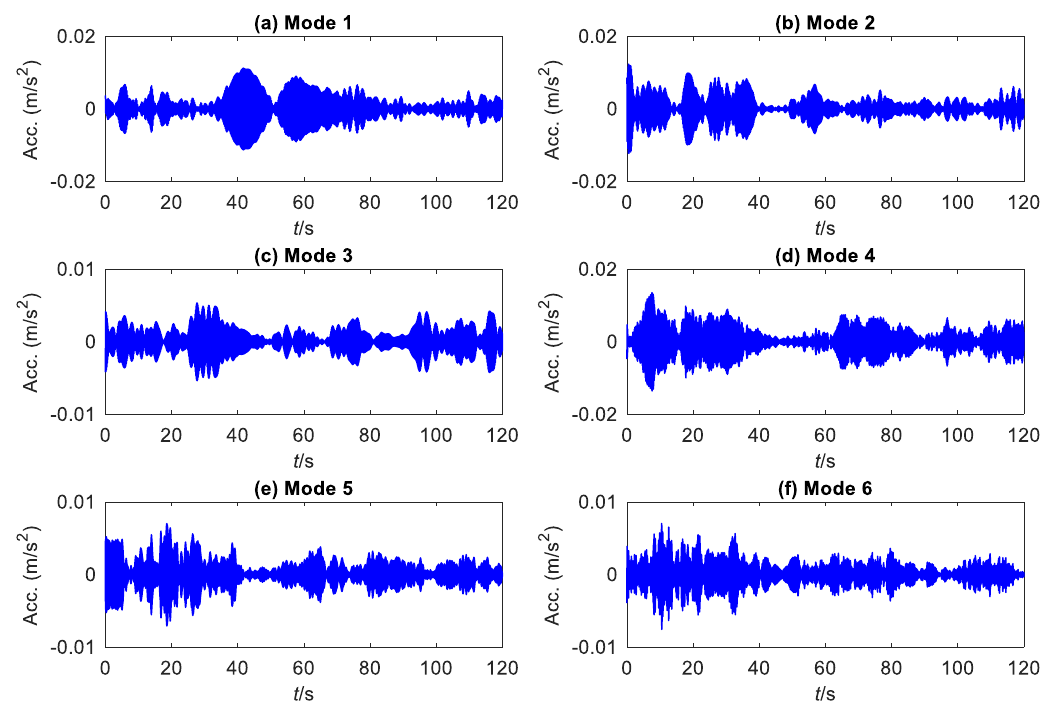
Figure 16. The first six components extracted from the acceleration signal of DHF by EWT (The Acc. represents acceleration). Table 3. Modal parameters identified from mono-components of DHF.